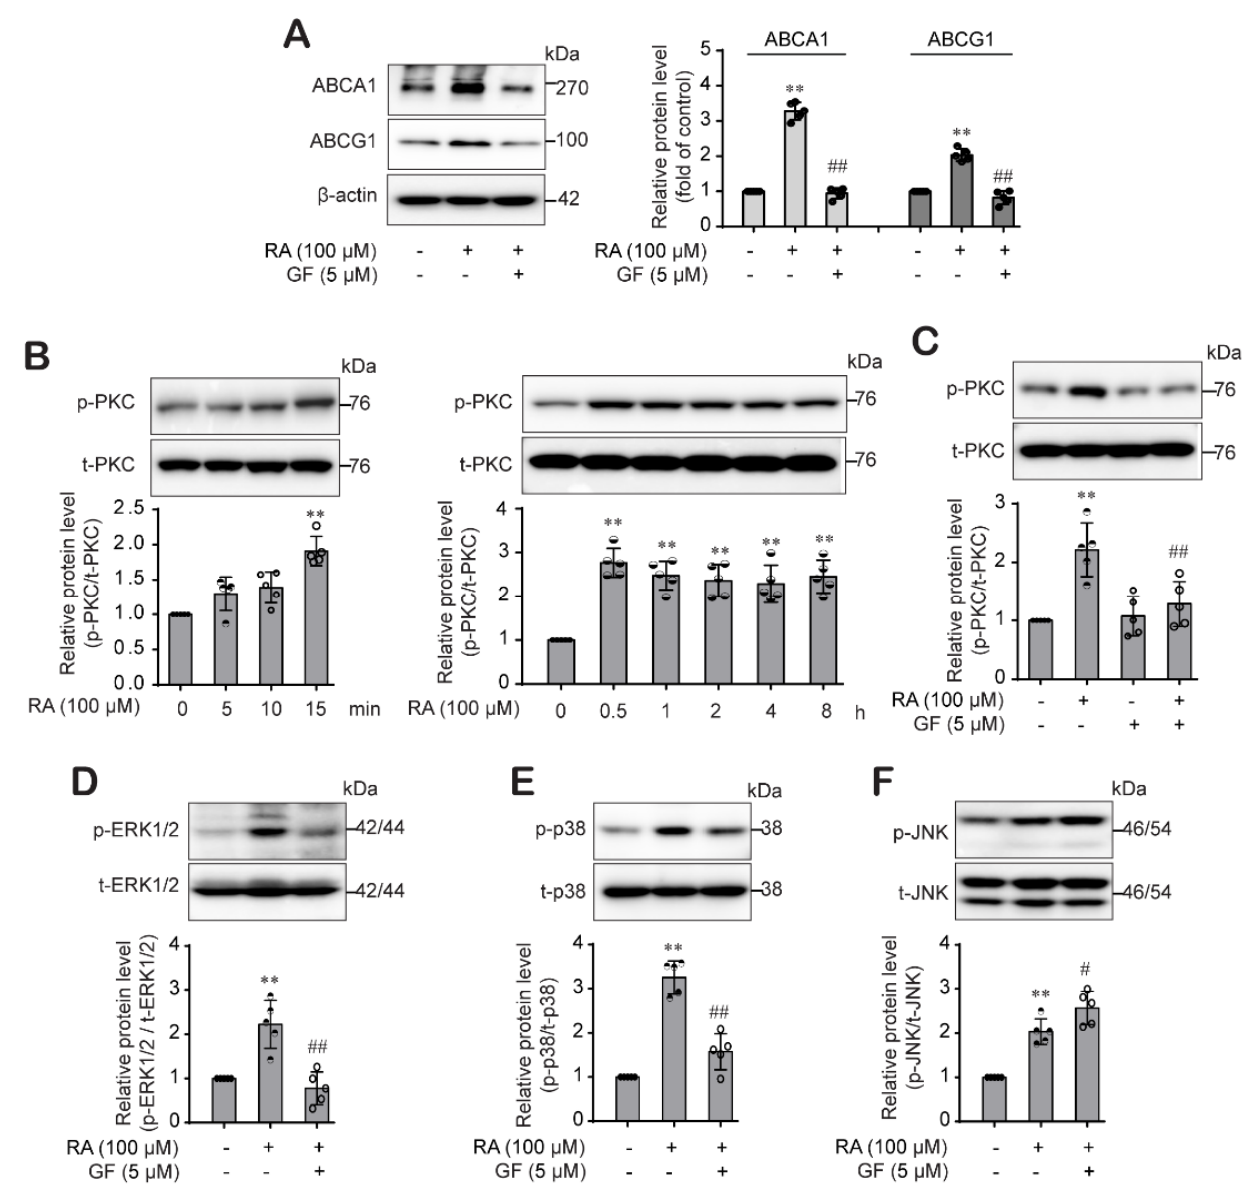
Figure 5. RA-activated PKC pathway was involved in the ABCA1 and ABCG1 expression by differentially regulating p38 and ERK1/2 but not the JNK pathway. ( A ) THP-1 macrophages were pretreated with GF109203X (a PKC inhibitor, 5 μ M) for 30 min and then treated with RA (100) for 24 h for the determination of ABCA1 and ABCG1 protein expression by western blot analysis. ( B ) Cells were treated with RA (100 μ M) in a time-dependent manner, and then phospho-PKC protein levels were determined by western blotting and normalized for the loading controls total PKC. ( C ) Cells were pretreated with GF109203X (5 μ M) for 30 min and then treated with RA (100 μ M) for an additional 15 min. Cell lysates were collected and phospho-PKC protein levels were determined by western blotting. ( D – F ) Cells were pretreated with GF109203X for 30 min and then treated with RA (100 µ M) for an additional 30 min or 1 h to measure phospho-ERK1/2 protein levels or phospho-p38 and phospho-JNK protein levels, respectively, from the cell lysate by western blotting. Band densities were quantified and normalized, and relative protein levels are presented as the mean ± SD ( n = 5). ** p < 0.01 compared to the control; # p < 0.05, ## p < 0.01 compared to the RA-treated